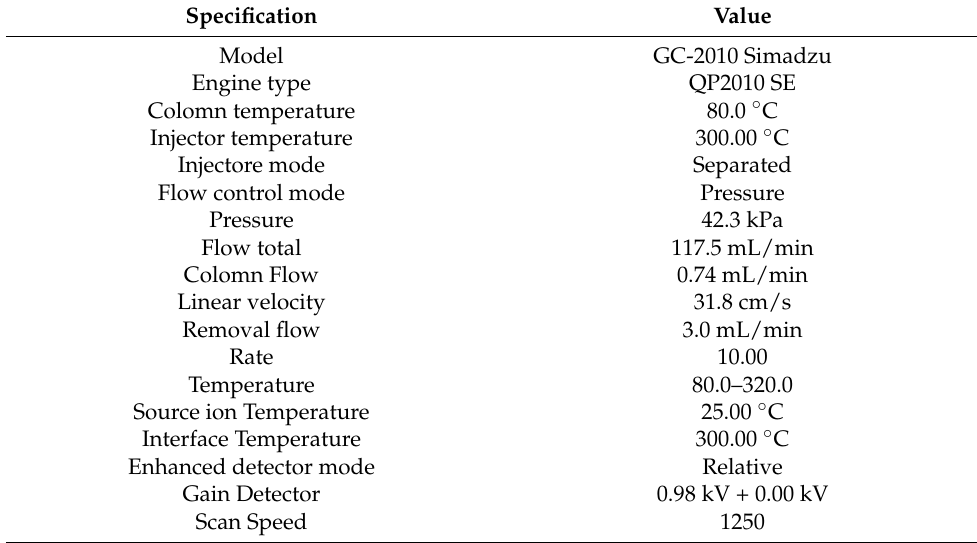
Table 2. Operational conditions of